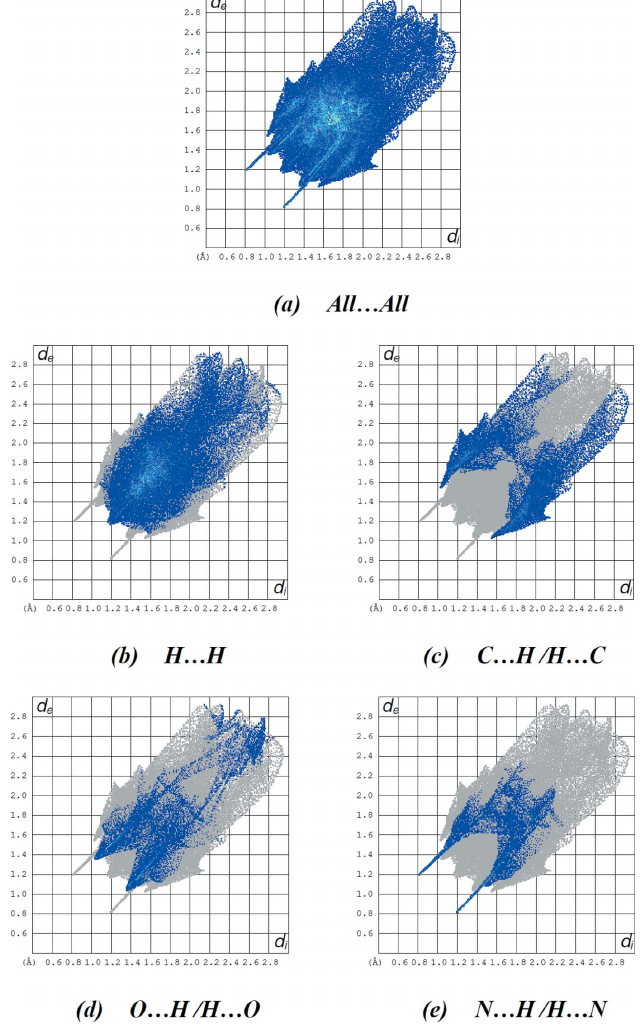
Figure 8 ( a ) The full two-dimensional fingerprint plot for the title compound and those delineated into ( b ) H (cid:2)(cid:2)(cid:2) H (47.1%), ( c ) C (cid:2)(cid:2)(cid:2) H/H (cid:2)(cid:2)(cid:2) C (20.9%), ( d ) O (cid:2)(cid:2)(cid:2) H/H (cid:2)(cid:2)(cid:2) O (15.3%) and ( e ) N (cid:2)(cid:2)(cid:2) H/H (cid:2)(cid:2)(cid:2) N (11.4%)